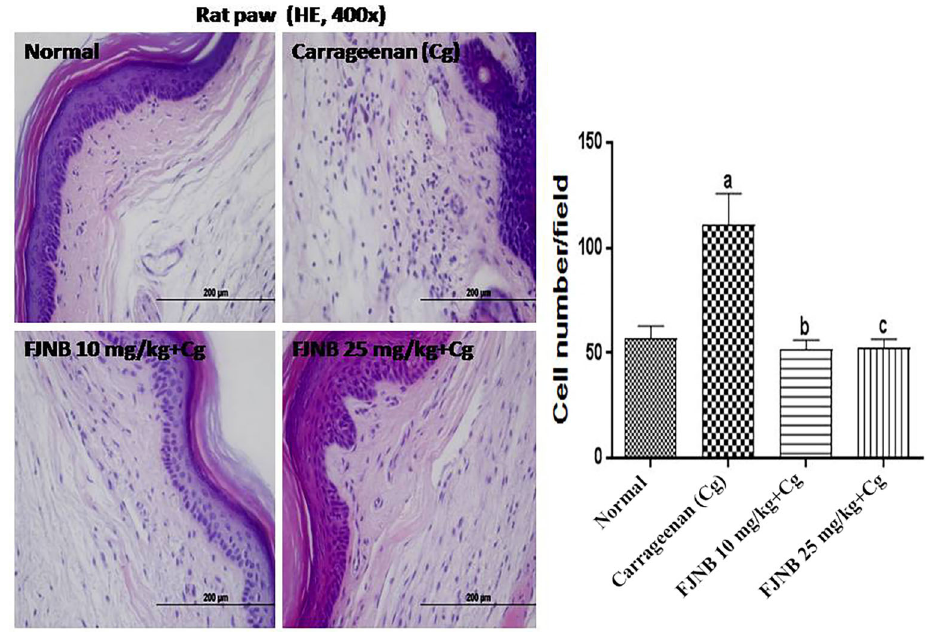
Figure 4. Photomicrographs of hematoxylin/eosin staining from paws of rats subjected to the carrageenan-induced edema test ( (cid:1) 400 magni fi cation, scale bar=200 m m). The triterpene-rich fraction from Himatanthus drasticus (FJNB) inhibited polymorphonuclear cell migration from in fl amed paws of rats. Data are reported as means ± SE. a P o 0.001 vs Normal; b P o 0.001 and c P o 0.001 vs carrageenan (one-way ANOVA and Tukey ’ s test for multiple